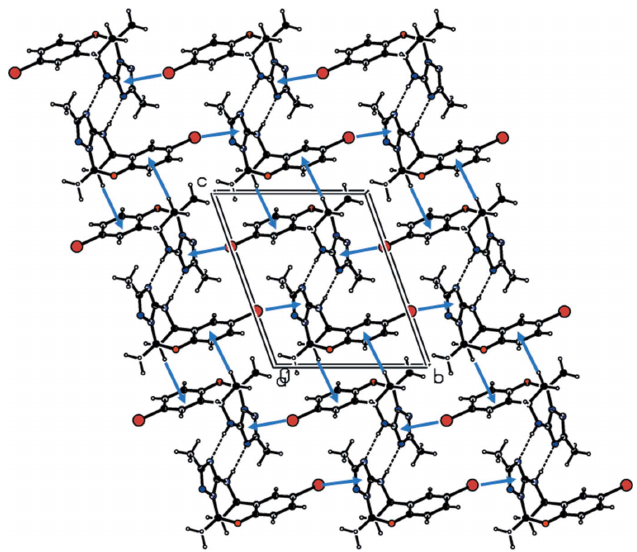
Figure 4 A view along the a axis of the crystal packing of compound I . Dashed lines denote the intermolecular N—H (cid:2)(cid:2)(cid:2) N hydrogen bonds, forming an inversion dimer with an R 2 (8) ring motif (Table 1). C—H (cid:2)(cid:2)(cid:2) (cid:2) and C— 2